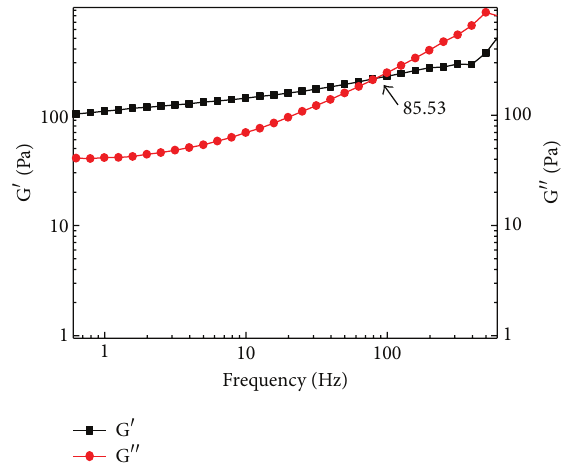
Figure 6: Rheology curves of liquid-like MWNTs nanofluids.